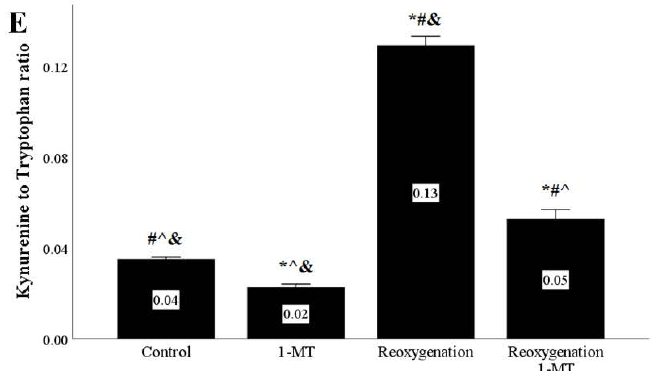
Figure 2. Reoxygenation upregulates IDO expression and activity. Cells were cultured under anoxic conditions for 24 h and then subjected to 2 h of reoxygenation along with the indicating treatments. Reoxygenation in the presence or not of 1-MT or CH223191 increased IDO protein level. A representative Western blot experiment is displayed in panel ( A ), whereas panel ( B ) depicts the cumulative results of four repeated experiments. * p < 0.05 vs. Control, # p < 0.05 vs. Control with 1-MT, ^ p < 0.05 vs. Control with CH223191, & p < 0.05 vs. Reoxygenation, + p < 0.05 vs. Reoxygenation with 1-MT, ! p < 0.05 vs. Reoxygenation with CH223191. IDO activity assessed by the ratio of kynurenine to tryptophan concentration in cell culture supernatants also increased under reoxygenation, an effect that is abolished by the IDO inhibitor 1-MT ( C – E ). Six such experiments were performed. * p < 0.05 vs. Control, # p < 0.05 vs. Control with 1-MT, ^ p < 0.05 vs. Reoxygenation, & p < 0.05 vs. Reoxygenation with 1-MT. Error bars correspond to SEM. 1-MT, 1-DL-methyltryptophan; IDO, indoleamine 2,3-dioxygenase 1; Reox, reoxygenation.